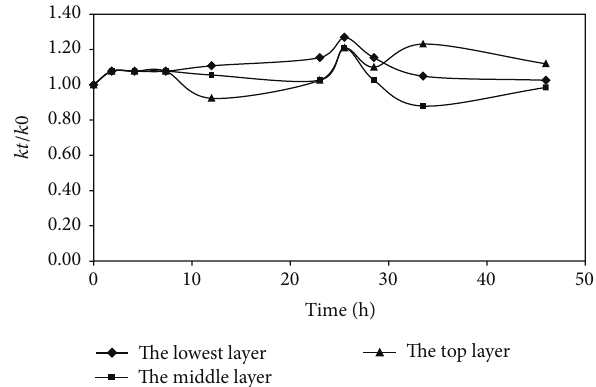
Figure 13: Relationship between 𝑘𝑡/𝑘0 and time in different layers under the hydraulic gradient of 0.125 (experiment 4).